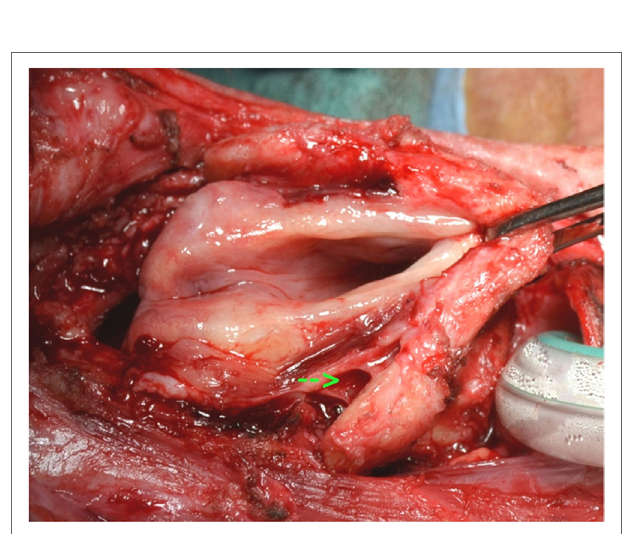
FigUre 1 | Neck incision for maximal mucosa sparing functional total